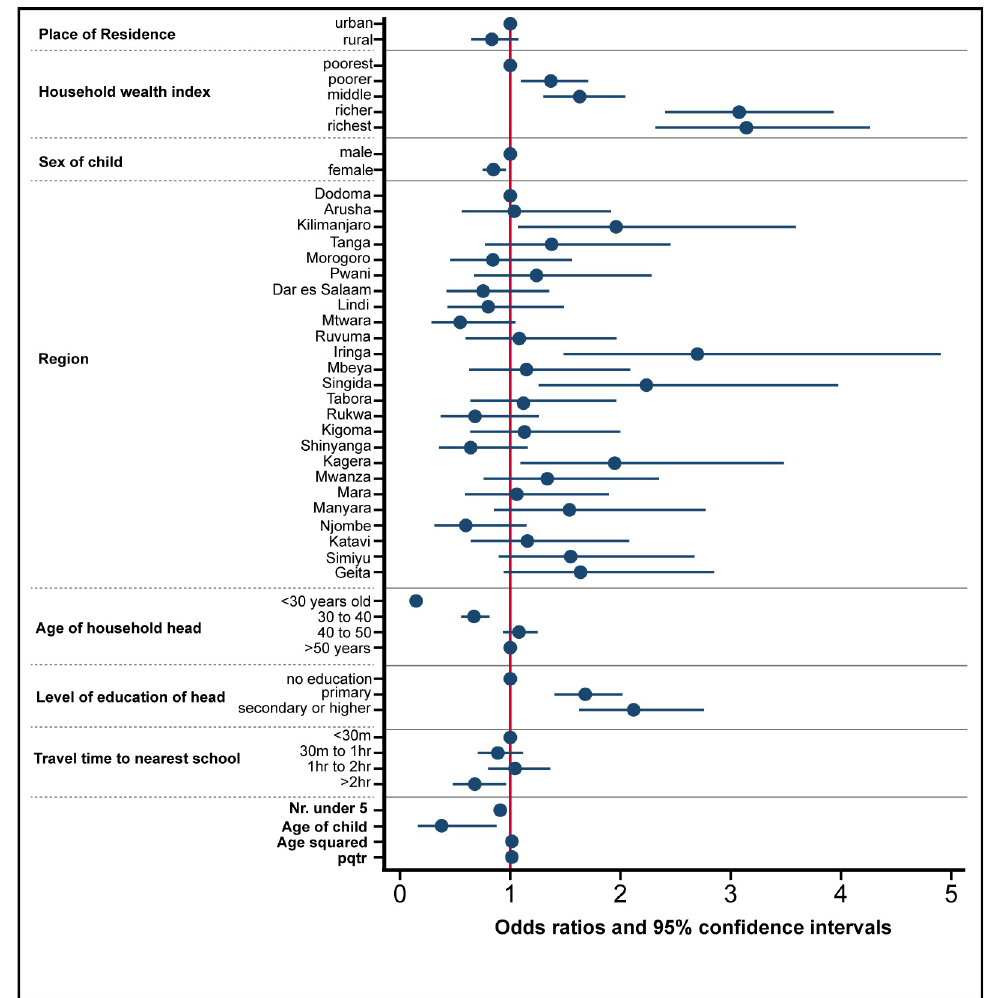
Fig 1. Plotted coefficients for fixed effect covariates from a multilevel-multivariate analysis of drivers of school attendance for Tanzania. Odds ratios and 95% confidence intervals from the two-level logistic regression model of school attendance among children of adolescents or youth-level using DHS data in Tanzania (2015–16 DHS, N = 6,197). Fixed effects only were plotted. A map of the regions of Tanzania is presented in S2 Fig.